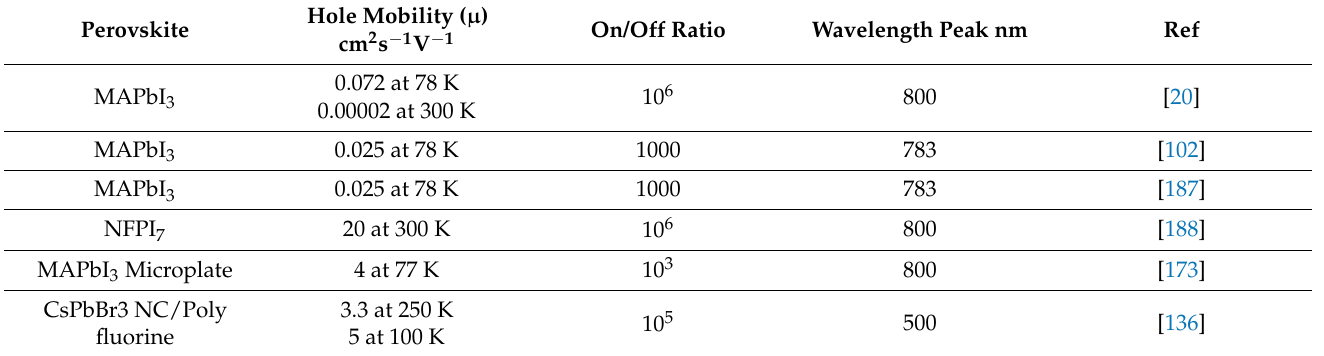
Table 7. The reported light-emitting FET devices based on the perovskite structured channels inthe